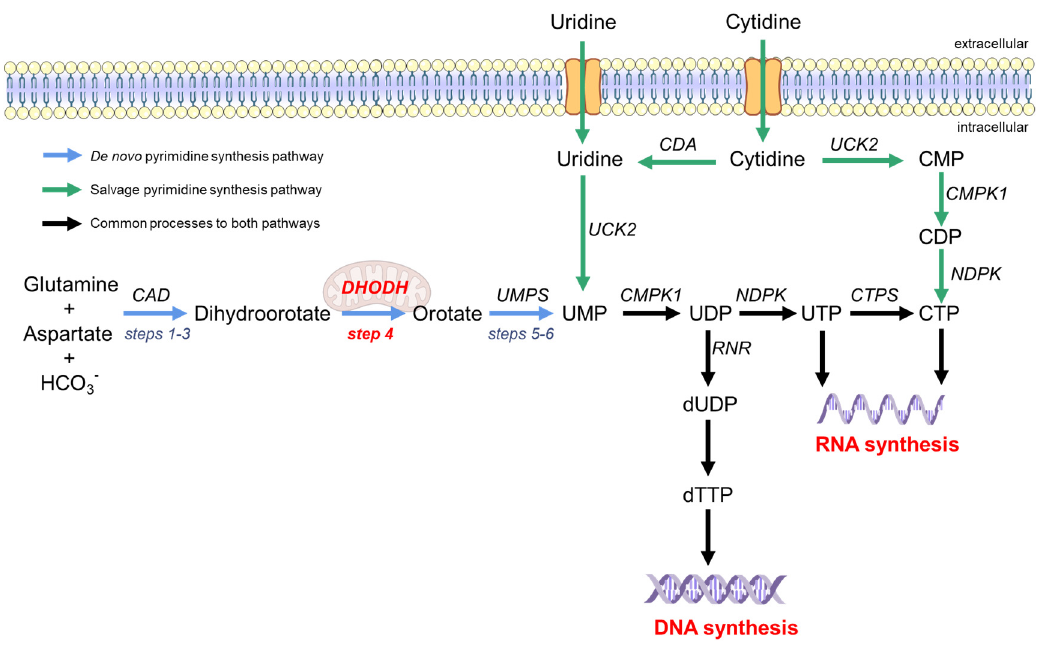
Figure 1. Pyrimidine synthesis pathway in humans. The de novo synthesis pathway of pyrimidine is represented by blue arrows, and the salvage pathway is represented by green arrows. The de novo synthesis pathway begins with dihydroorotate from glutamine and aspartate under the action of CAD multifunctional enzymes (steps 1–3). The mitochondrial inner membrane protein DHODH oxidizes DHO to produce orotate (step 4). Orotate is subsequently phosphorylated and produces UMP from the bifunctional enzyme UMPS (steps 5–6). In the salvage pathway, exogenous uridine and cytidine can be transformed into UMP and CTP, respectively. UDP is the raw material for DNA synthesis. CTP and UTP are the raw materials for RNA synthesis. CAD, carbamoyl phosphate synthetase, aspartate transcarbamoylase, and dihydroorotase; UMP, uridine monophosphate; DHODH, dihydroorotate dehydrogenase; UDP, uridine diphosphate; UTP, uridine triphosphate; CMP, cytidine monophosphate; CDP, cytidine diphosphate; CTP, cytidine triphosphate; CTPS, CTP synthase; dUDP, deoxy-UDP; dTTP, deoxythymidine triphosphate; UMPS, uridine monophosphate synthetase; CMPK, cytidine monophosphate kinase; NDPK, nucleoside-diphosphate kinase; CDA, cytidine deaminase; UCK, uridine or cytidine kinase; RR, ribonucleotide reductase.